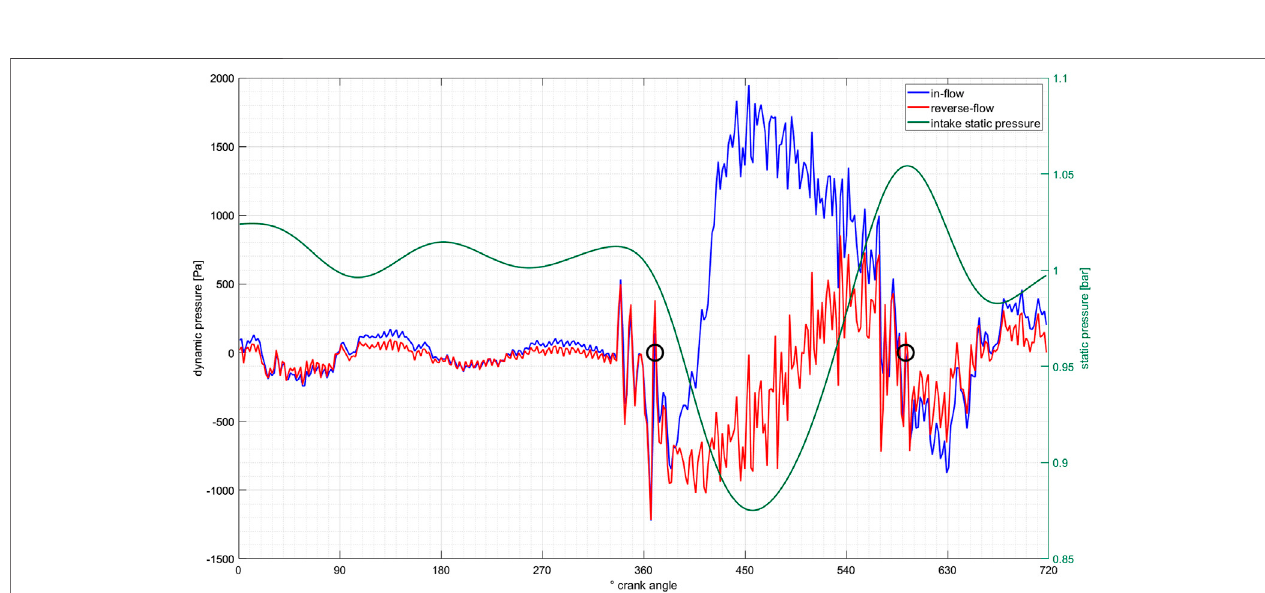
FIGURE 6 | Recorded mass fl ow rate using the Vecto fl ow probes and the HFM. Conditions identical to Figure 4 .